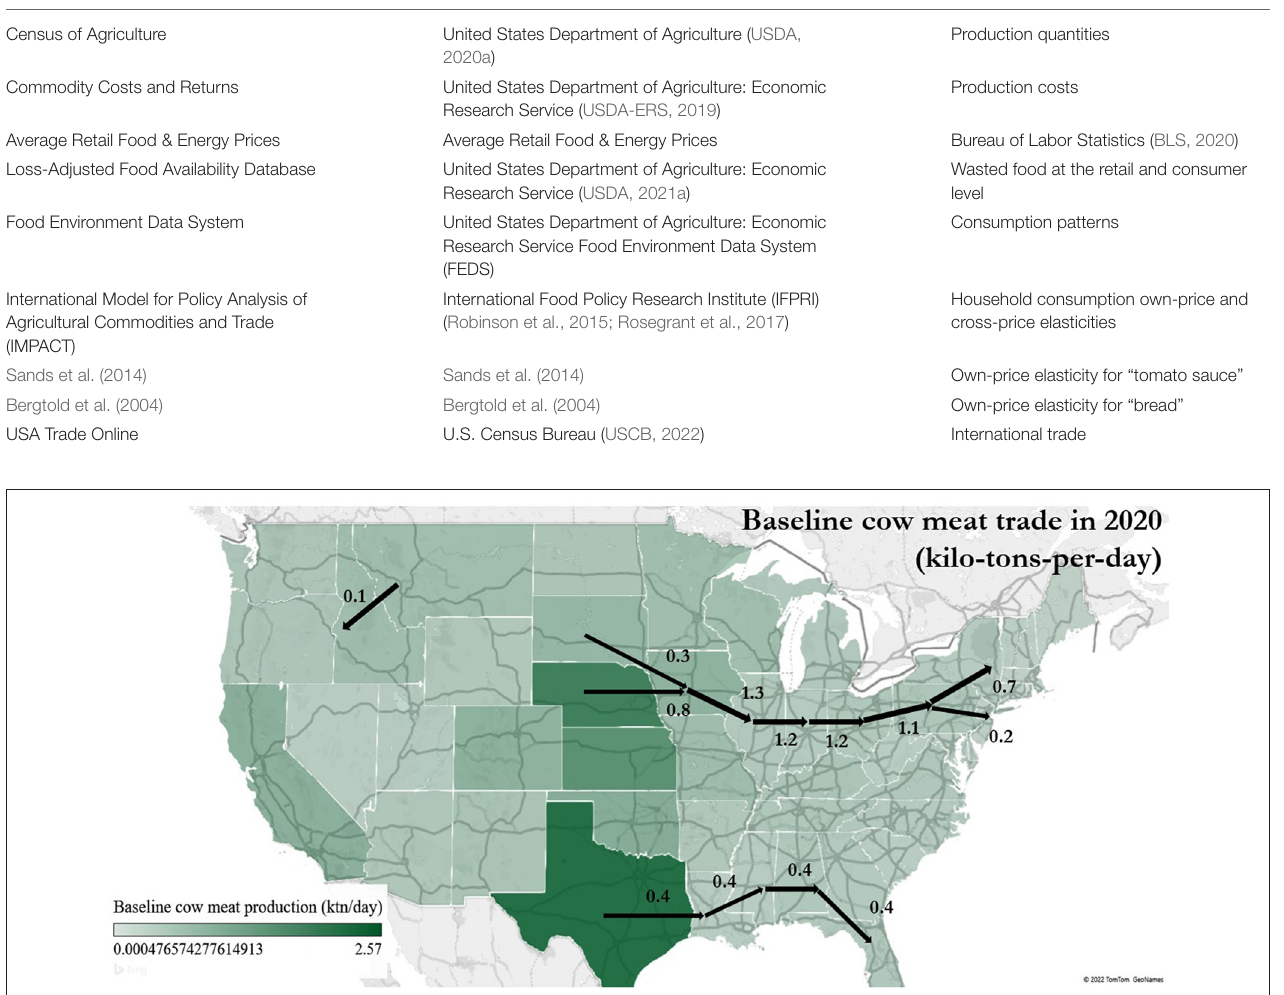
FIGURE 2 | Generated data: baseline cow meat trade between selected states in 2020 in kilo-tons-per-day. Baseline cow meat production varies regionally. Food trade in the US-FEAST food model is driven by the state-level mismatch between production and total consumption, and the difference of wholesale prices between